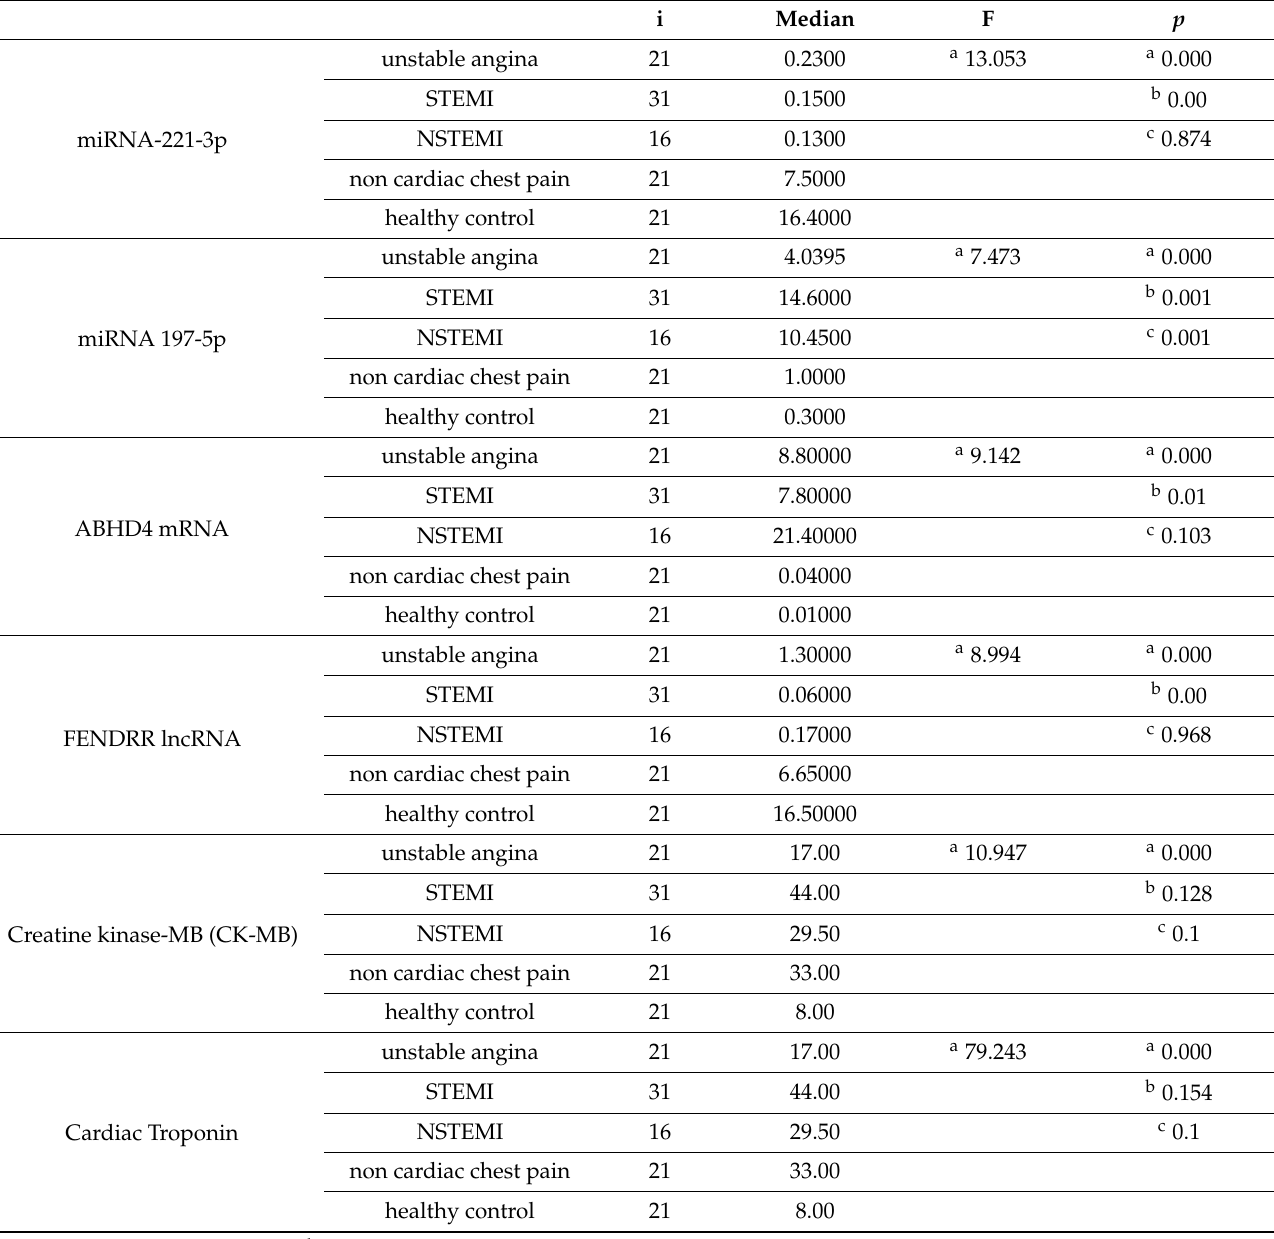
Table 1. Differential expression of different parameters among the study groups, in addition to patients with unstable angina versus